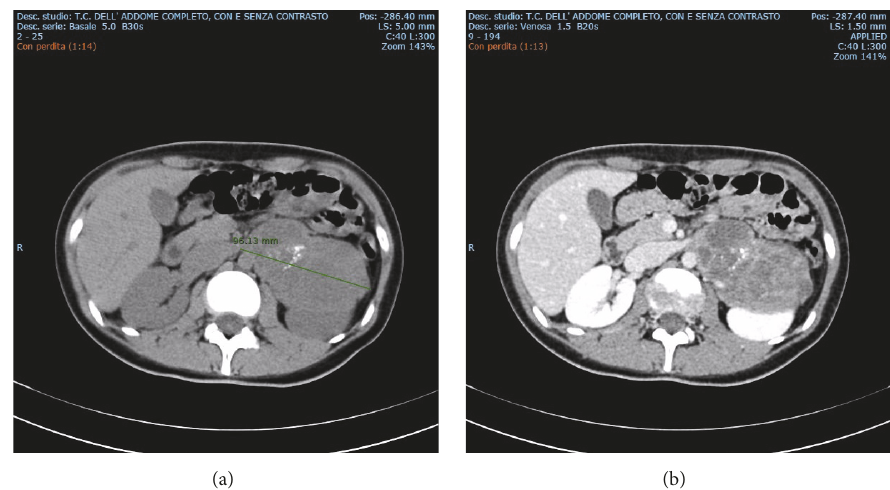
Figure 1: Abdominal CT scan with and without contrast enhancement: presence of a big and heterogeneous mass with calcification in left adrenal lodge (b). Dynamic analysis revealed a progressive and modest contrast enhancement in venous phase (a).